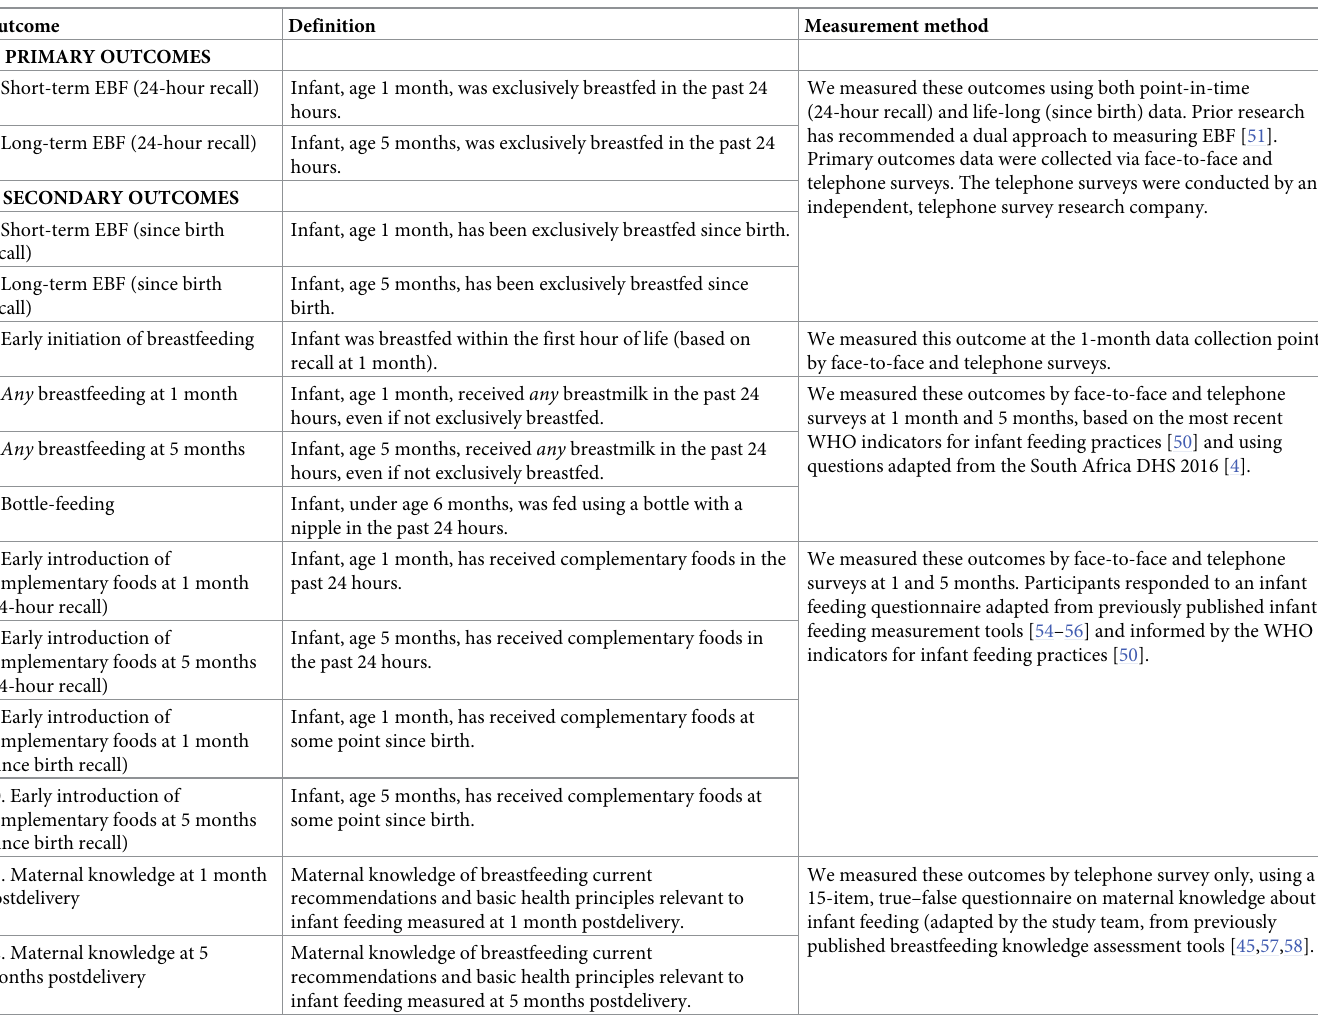
Table 1. Primary and secondary outcomes of the Philani MOVIE